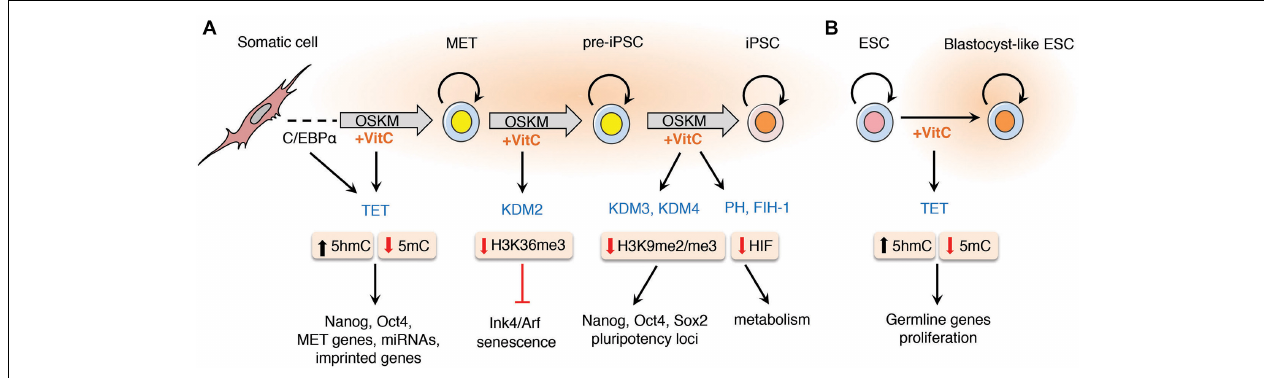
FIGURE 1 | Vitamin C promotes somatic cell reprogramming by enhancing the activity of α -KGDDs. The addition of vitamin C to the culture medium of somatic cells during reprogramming enhances the activity of α -ketoglutarate dependent dioxygenases ( α -KGDDs) including Jumonji-C domain-containing histone demethylases (JHDMs/KDMs), ten-eleven translocation (TET) proteins, prolyl hydroxylases (PH) and the asparaginyl hydroxylase FIH-1. (A) During somatic cell reprogramming it has been shown that transient C/EBP α expression up-regulates Tet2 expression that primes cells for mesenchymal-to-epithelial transition (MET). MET is an essential step required for the initiation of reprogramming that is dependent on TET-mediated DNA hydroxylation and demethylation of the enhancers and promoters of pluripotency genes (e.g., Nanog and Oct4) and for the expression of MET genes, miRNAs and to prevent hypermethylation and silencing of imprinted loci. The hypomethylation of histones by JHDMs such as KDM2 targets H3K36me3 for demethylation that suppresses the expression of senescence-inducing factors Ink4/Arf. Vitamin C also increases loss of H3K9me2/me3 by enhancing KDM3/4 activity to maintain expression at pluripotency loci during the final stages of reprogramming pre-iPSCs in to fully pluripotent iPSCs. Vitamin C may also reduce oxidative stress and increase the activity of hypoxia-inducible factor (HIF) prolyl hydroxylases and FIH-1 that promote the degradation of HIF that has also been shown to be important in the final stage of reprogramming. (B) Vitamin C treatment increases the proliferation of embryonic stem cells (ESCs) in culture and promotes demethylation of germline genes by enhancing TET activity to replicate the naïve “ground-state” of blastocyst-derived ESCs.